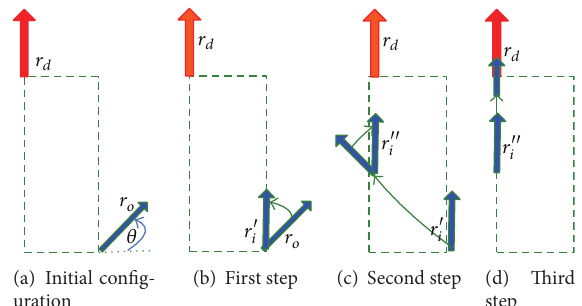
Figure 3: The scheme of three-step epipolar-based visual servoing system. (a) The initial configuration of the mobile robot; (b) the first step that the mobile robot will move from 𝑟 𝑜 to 𝑟 󸀠 𝑖 ; (c) the second step that the mobile robot will move from the 𝑟 󸀠 𝑖 to 𝑟 󸀠󸀠 𝑖 ; (d) the third step that the mobile robot will move from the 𝑟 󸀠󸀠 𝑖 to 𝑟 𝑑 .